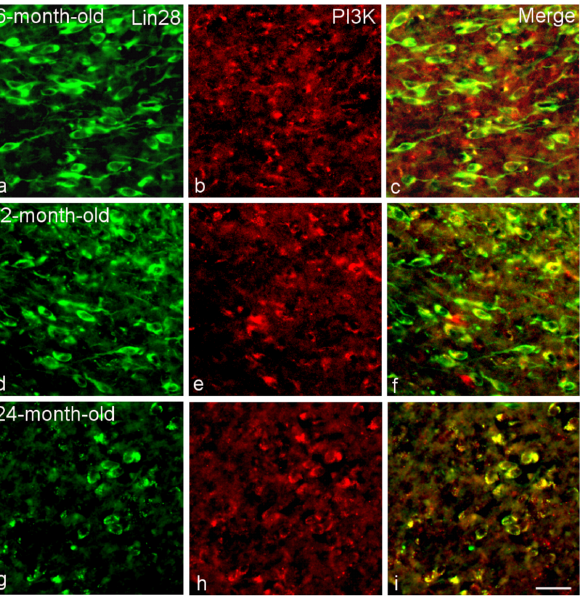
Figure 5. Colocalization of Lin28 with PI3K in the VMH neurons of 6-month-old ( a – c ), 12-month-old ( d – f ) and 24-month-old ( g – i ) male rats. Double labeling of Lin28 ( a , d , g , green, left panel), PI3K ( b , e , h , red, middle) and composite image ( c , f , i , right). Bar, 25 µm.